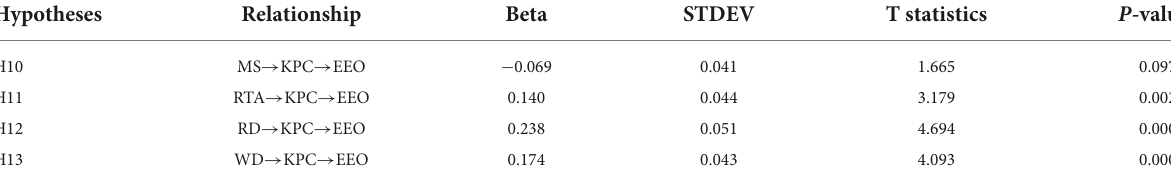
TABLE 6 Structural model assessment [indirect (mediation) effect results and decision].